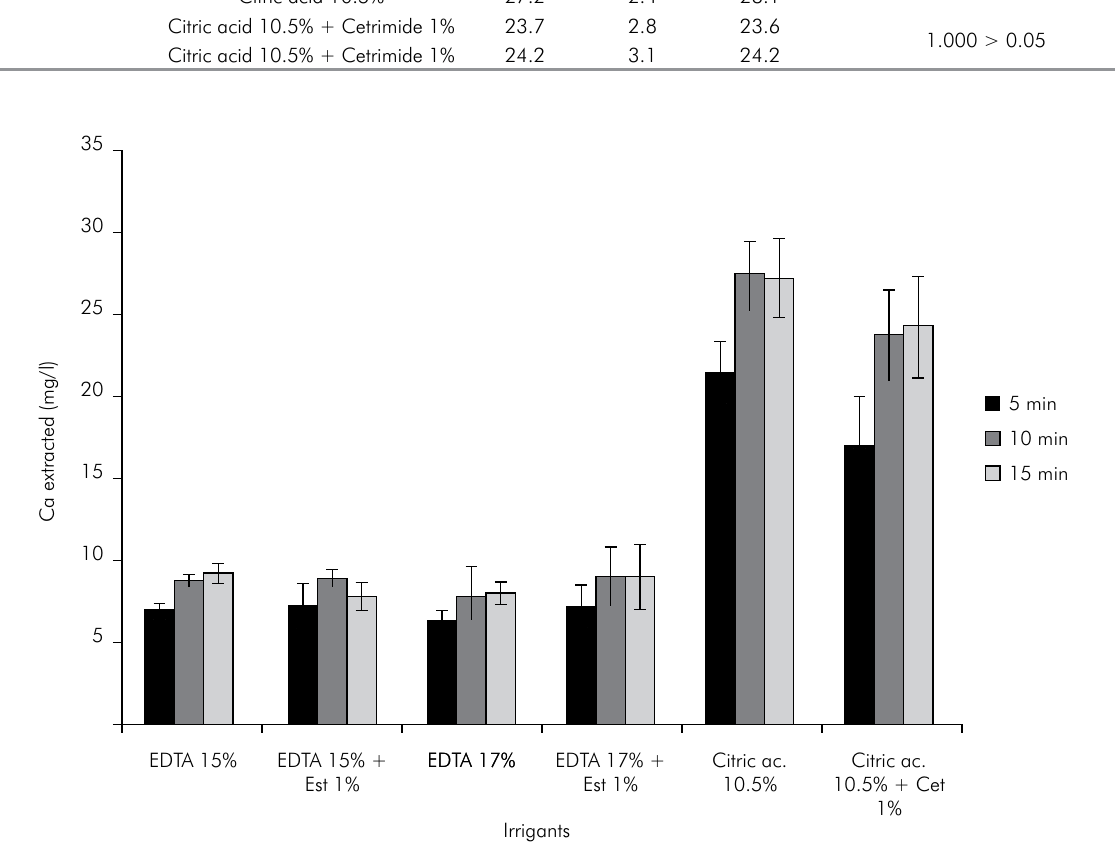
Figure. Amount of calcium extracted (mg/l Ca2+ - mean value of 5 replicates) with five irrigating solutions at different immersion times. The error bars represent the SD.